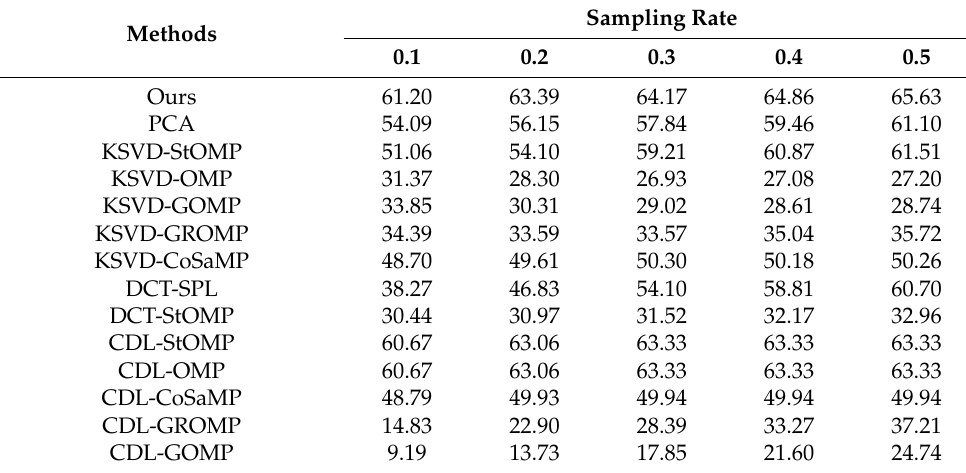
Table 1. The reconstructed average peak signal-to-noise ratio (PSNR) (dB) of hyperspectral images in all bands under different sampling rates.